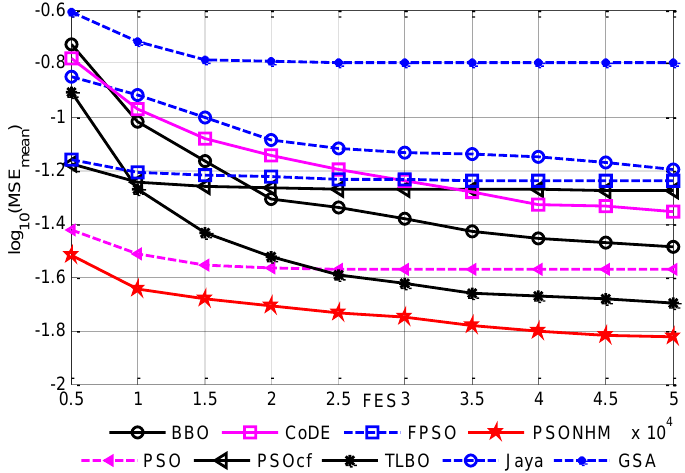
Figure 6. Convergence curves of nine algorithms for the Iris dataset.